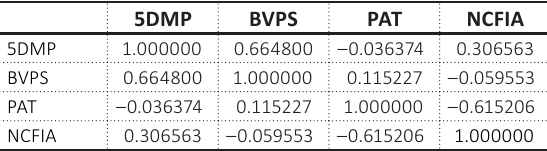
Table 3. Pearson correlation, pre-Ind AS